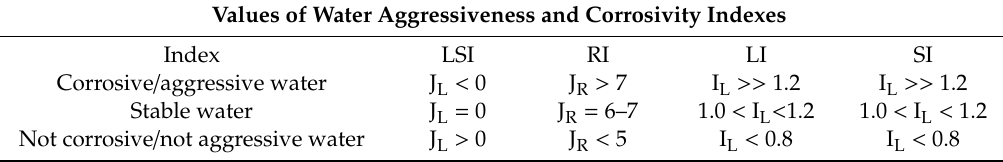
Table 3. Values of water aggressiveness and corrosivity indicators. LSI, Langelier Saturation Index; RI, Ryznar Stability Index; LI, Larson–Skold Index (LI); SI, Singley Index. Values of Water Aggressiveness and Corrosivity